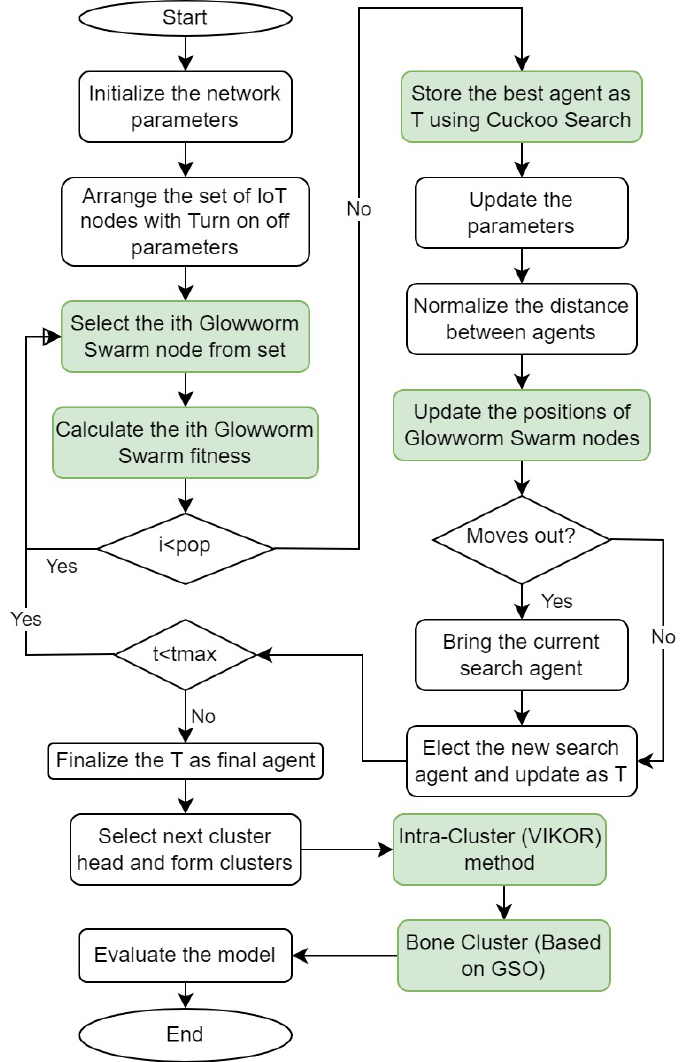
Figure 3. Hybrid integration of VIKOR GSO model for clustering in